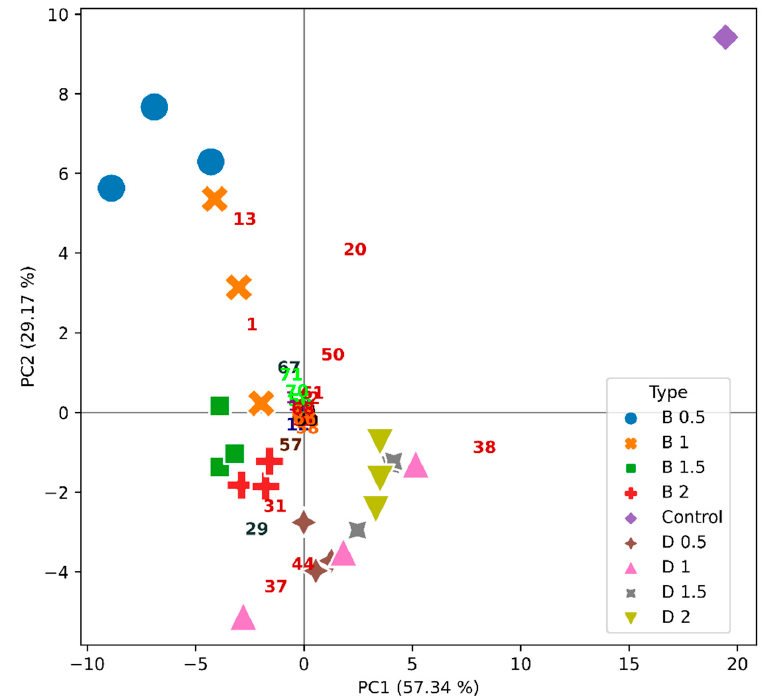
Figure 8. PCA illustrating the simultaneous projection of the wine samples (objects)—by a mark, and VOC (variables) loadings—by a number, for the Viosinho varietal wine. The different concentrations of bentonite (B) or DCMC (D) in g/L are indicated.